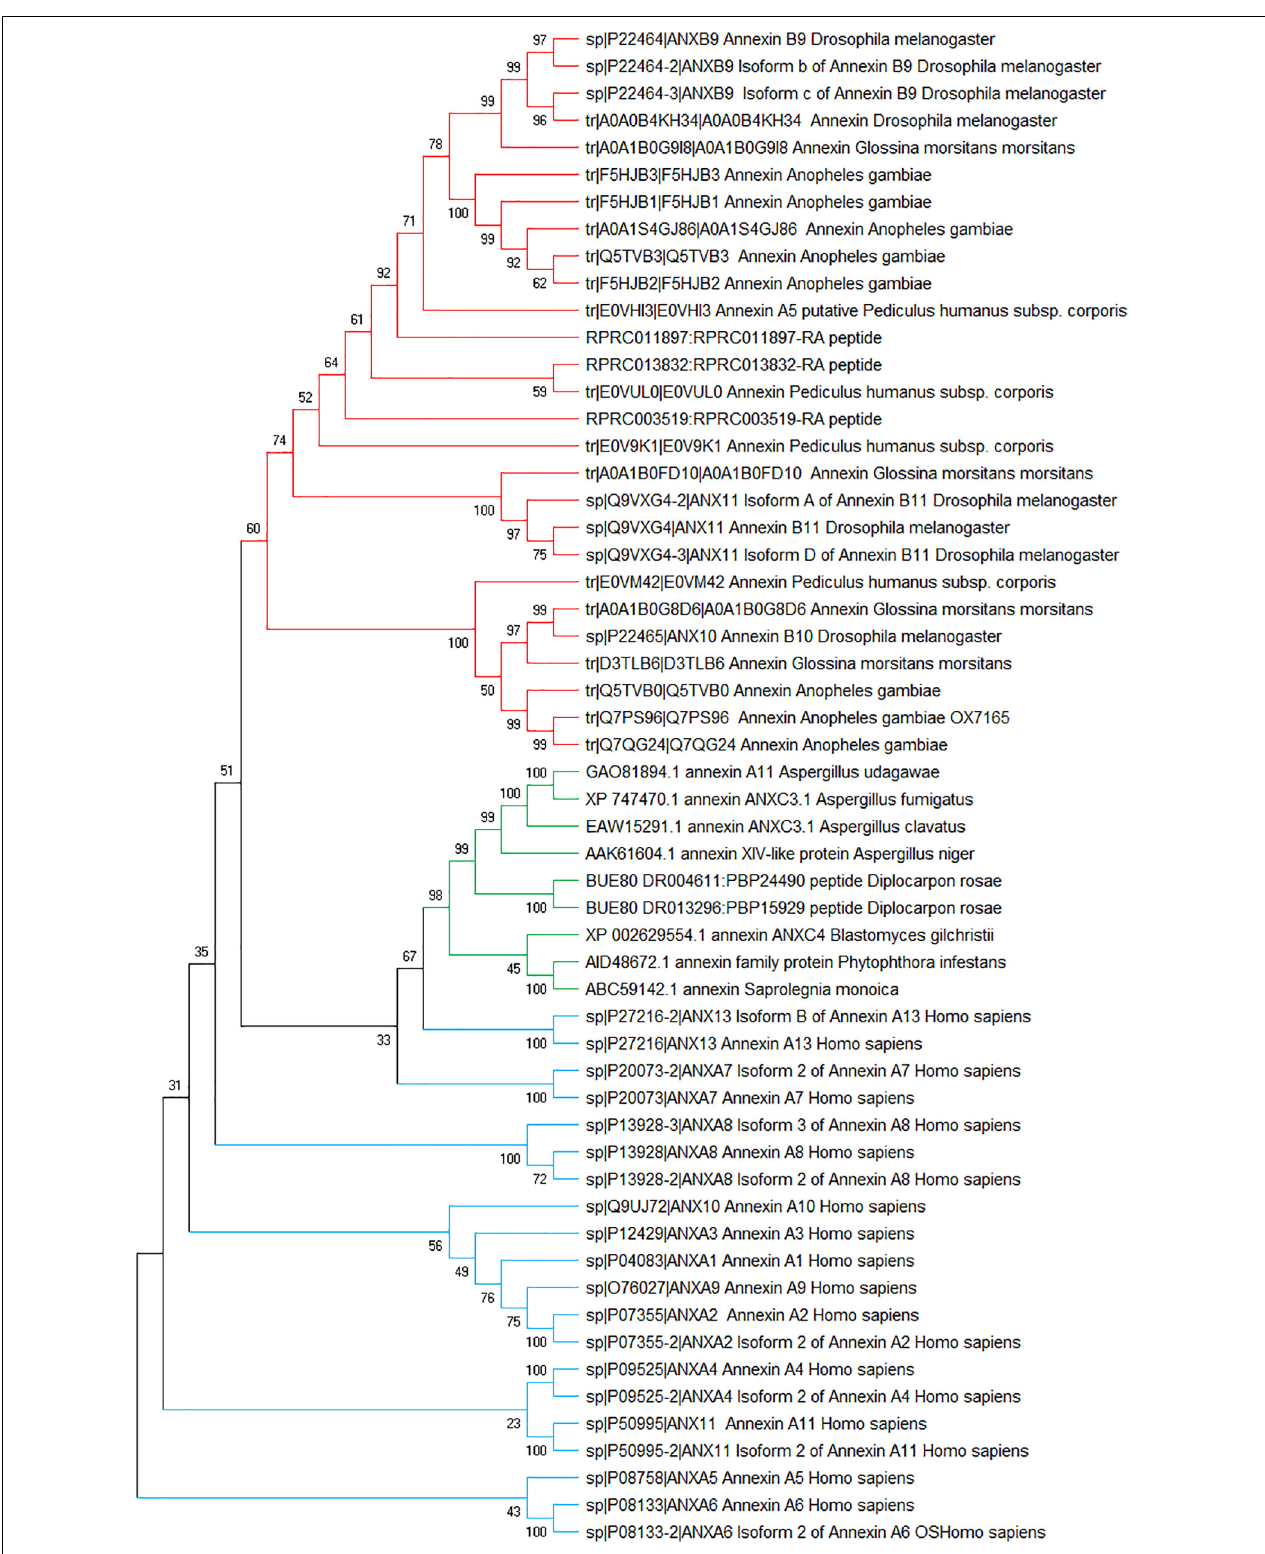
FIGURE 5 | Phylogenetic tree of annexin sequences from fungi, insects, and humans. Non-rooted NJ phylogenetic tree was constructed with MEGA-X4. The numbers adjacent to the branches represent bootstrap values based on 10,000 replicates.